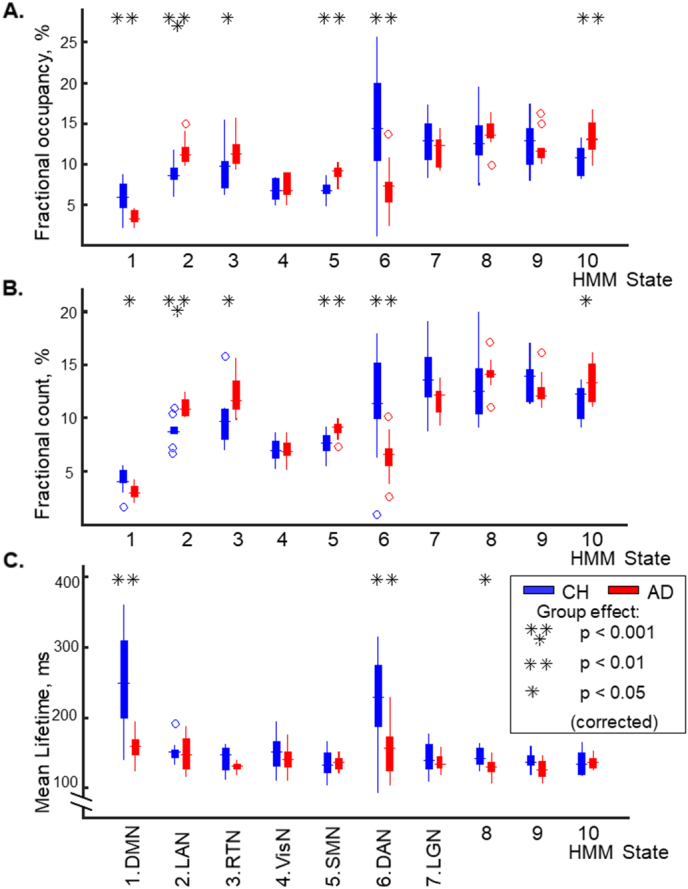
Group differences in temporal characteristics of the inferred HMM states.A. Fractional occupancy, or the proportion of time spent in each state. B. Fractional count, or the number of visits to each state as a proportion of the number of all state transitions. C. Mean lifetime, or the mean duration of the visits to each state. Boxplots for the seven salient states (1–7), labeled in the bottom, and for the three transitional states (8–10) show medians, 25th/75th percentiles, and outliers; whiskers extend to most extreme points but for outliers. Abbreviations are the same as in Fig. 2.